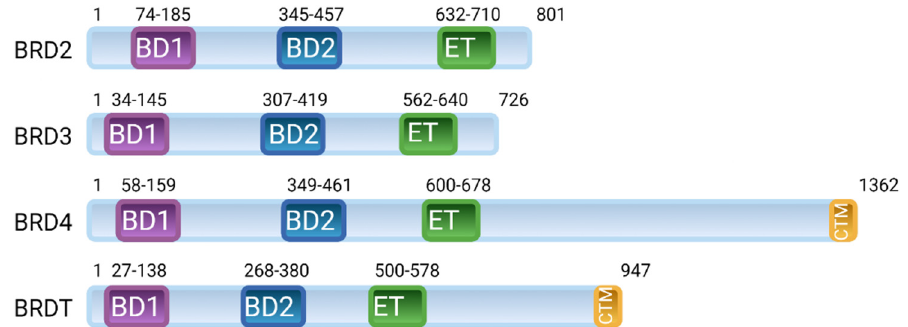
Figure 1. Arrangement of domains in the human bromodomain and extraterminal domain (BET) family of proteins; BRD2, BRD3, BRD4 and BRDT. BET proteins contain two N-terminal bromodomains (BD1 and BD2), an extraterminal domain (ET) and a C-terminal motif (CTM).